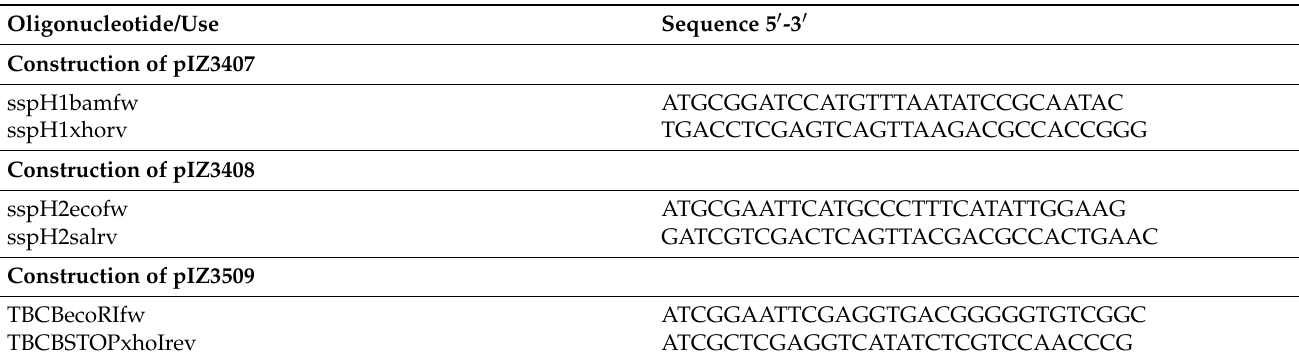
Table 2. Oligonucleotides used in this